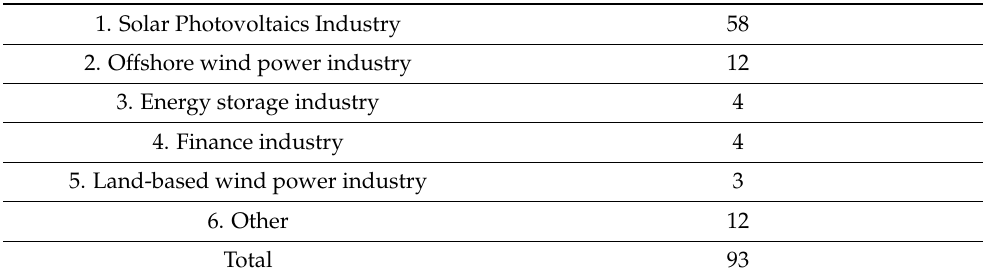
Table 3. The main business of the surveyed companies.